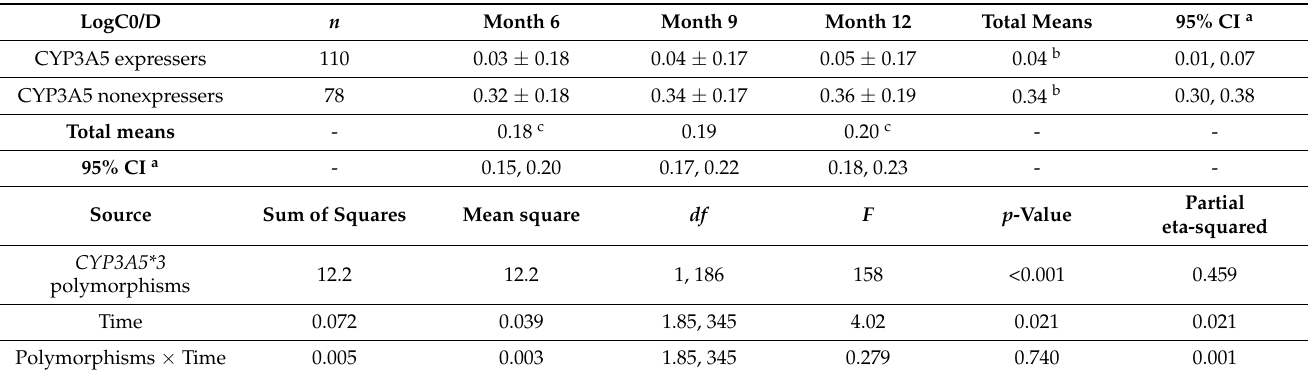
Table 3. Two-way mixed analysis of variance results for the logarithm of dose-adjusted tacrolimus trough concentrations.